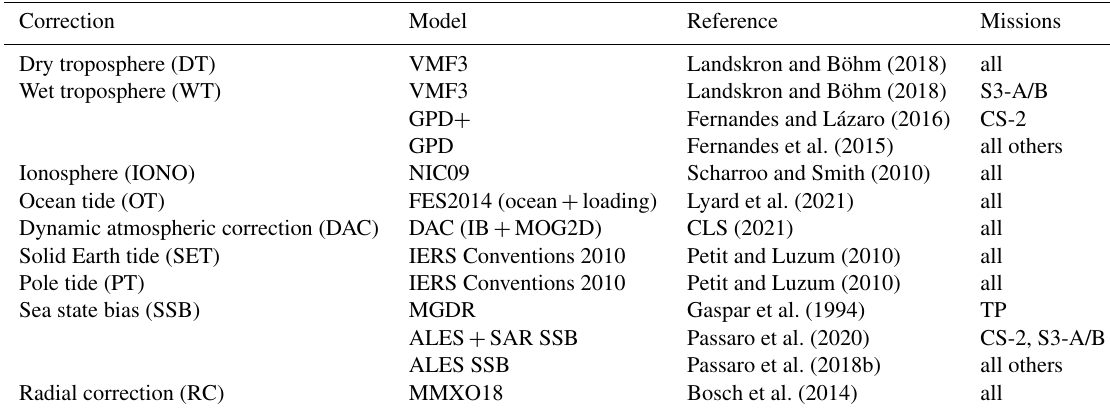
Table 1. Geophysical corrections applied to the along-track altimetry